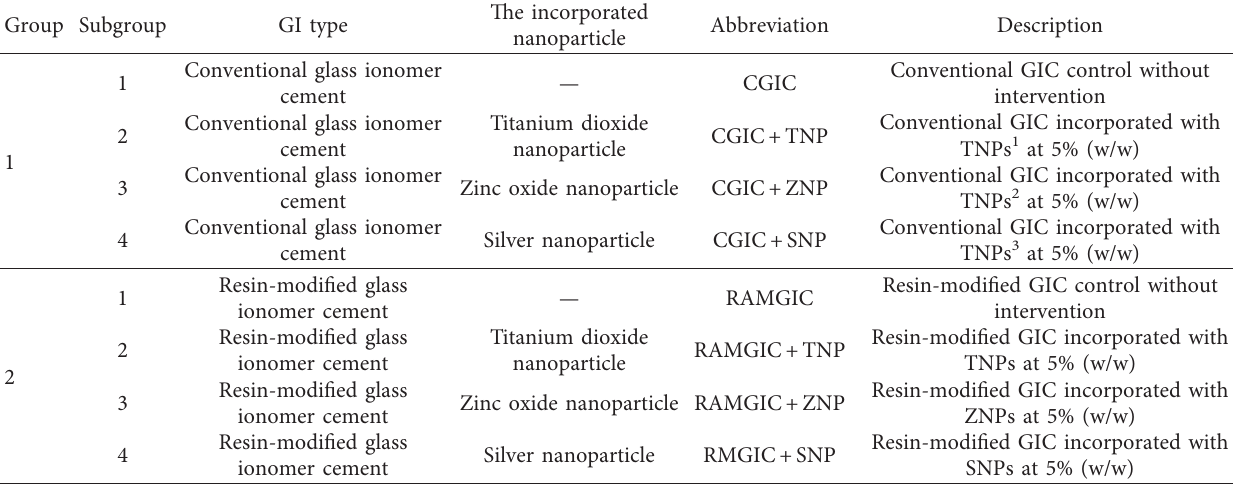
Table 1: The details of the experimental groups.